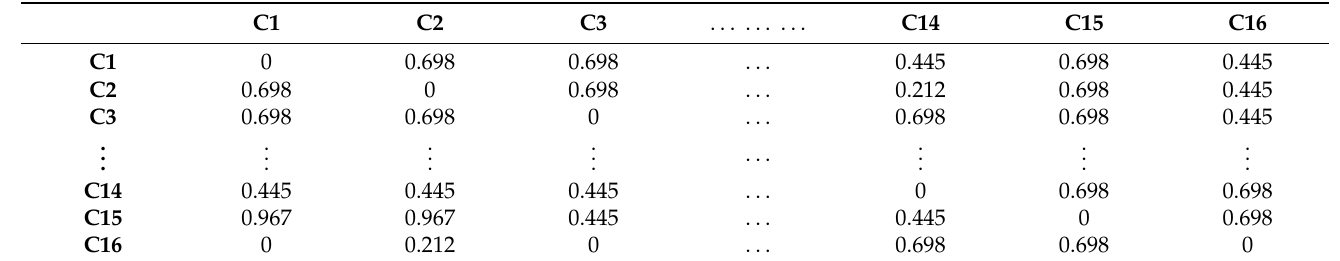
Table 8. Crisp values.